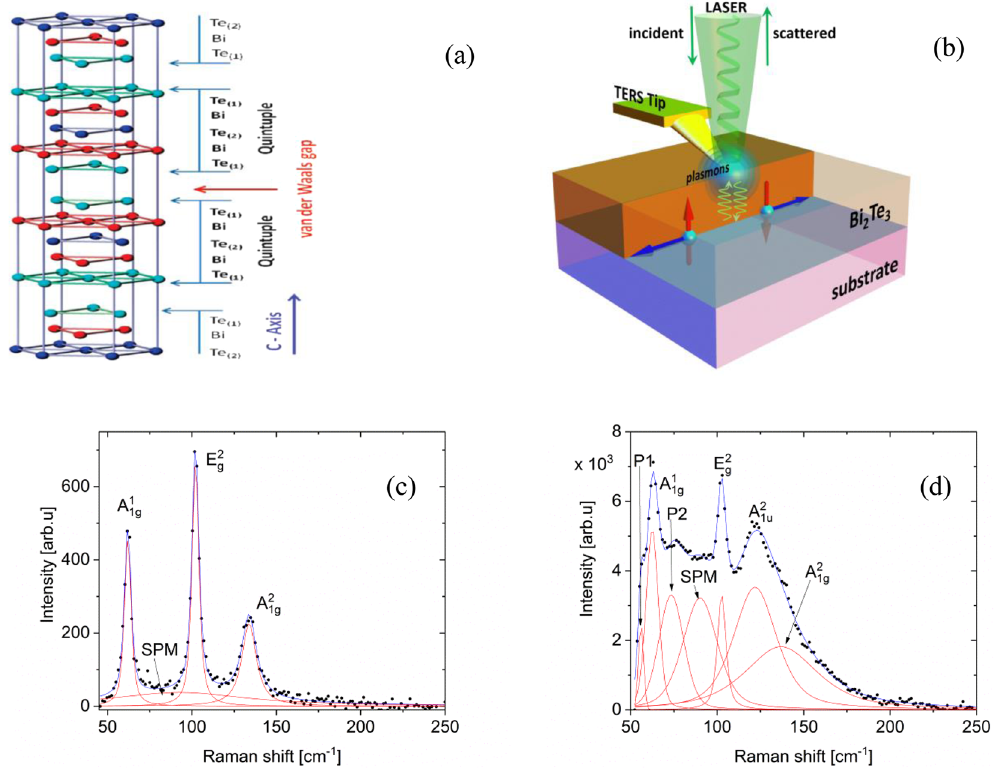
Figure 1. ( a ) Crystal structure of Bi 2 Te 3 highlighting quintuple layers (QLs) and the van der Waals gap. ( b ) Illustration of the tip-enhanced Raman spectroscopy (TERS) technique. Characteristic ( c ) micro-Raman and 11 and A 12 modes are out-of-plane vibrations with ( d ) TERS spectra of Bi 2 Te 3 on a flat sapphire substrate. The A g g 2 mode represents an in-plane vibration. The respect to the plane of van der Waals-bonded layers, while the E g intensities of the P1 and P2 modes are related to the Bi concentration and the SPM mode to the thickness 12 mode is IR-inactive and present in Raman spectra collected from thin TI layers. A detailed reduction. The A u description of the modes denoted with red lines is available in the Results section and in the Supplementary